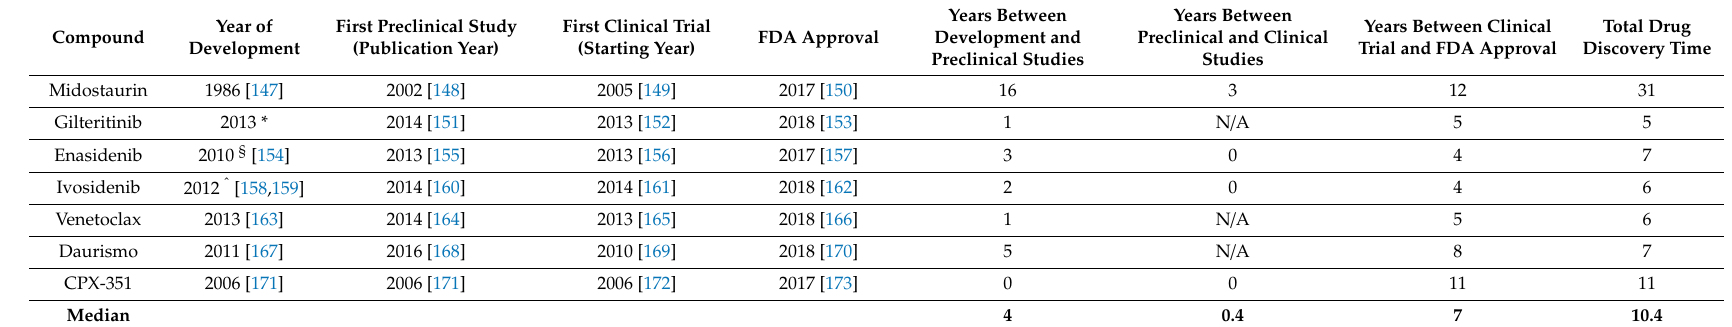
Table 3. Development times of FDA-approved de novo agents for AML